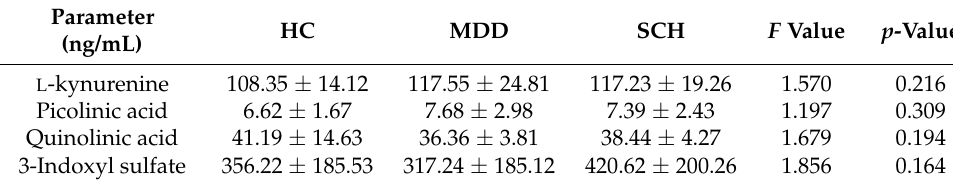
Table 2. Trp metabolites with no significant difference among the three